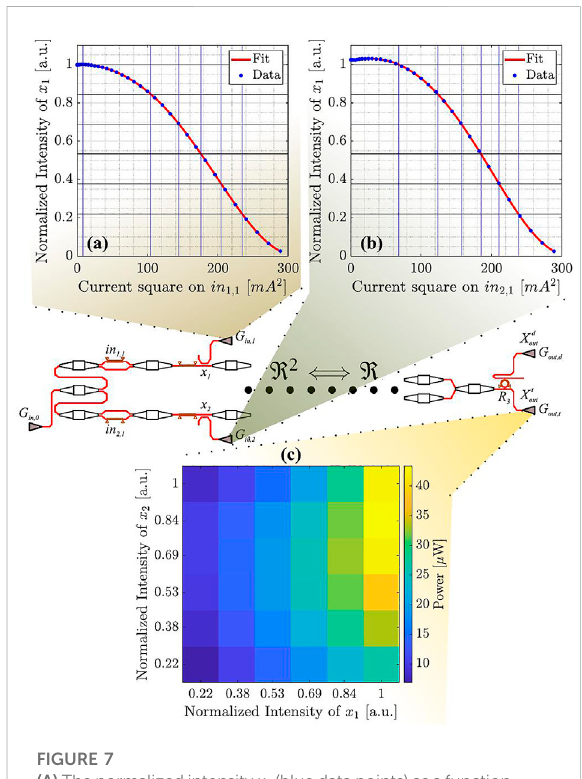
FIGURE 7 (A) Thenormalizedintensity x 1 (blue datapoints) asafunction of the square current in 1,1 applied to the microheater which controls the phase shifter in the fi rst MZI. The red line fi ts the data with the MZI response. The black vertical and blue horizontal lines de fi ne the discretized points used to build the domain set. (B) same as (A) for x 2 . The inset shows a sketch of the neural network with evidenced thegratings from whichthedifferentexperimental data are collected. (C) The output co-domain as a function of the input domain set. It is built by measuring the untrained neural network